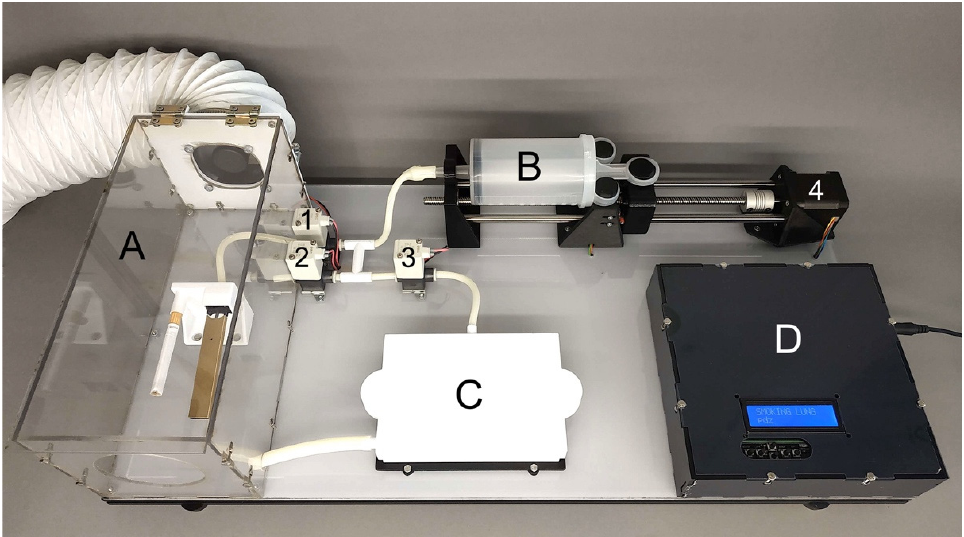
Figure 1. Smoking Lung device. ( A ) Smoking chamber with the cigarette holder. ( B ) Syringe pump for puff creation and dilution. ( C ) “Lung” = exposure chamber for 24-well plates. ( D ) Box for microcontroller and LCD screen for parameter selection. ( 1 ) Smoke valve. ( 2 ) Air and exhaust valve. ( 3 ) Exposure valve and ( 4 ) motor.